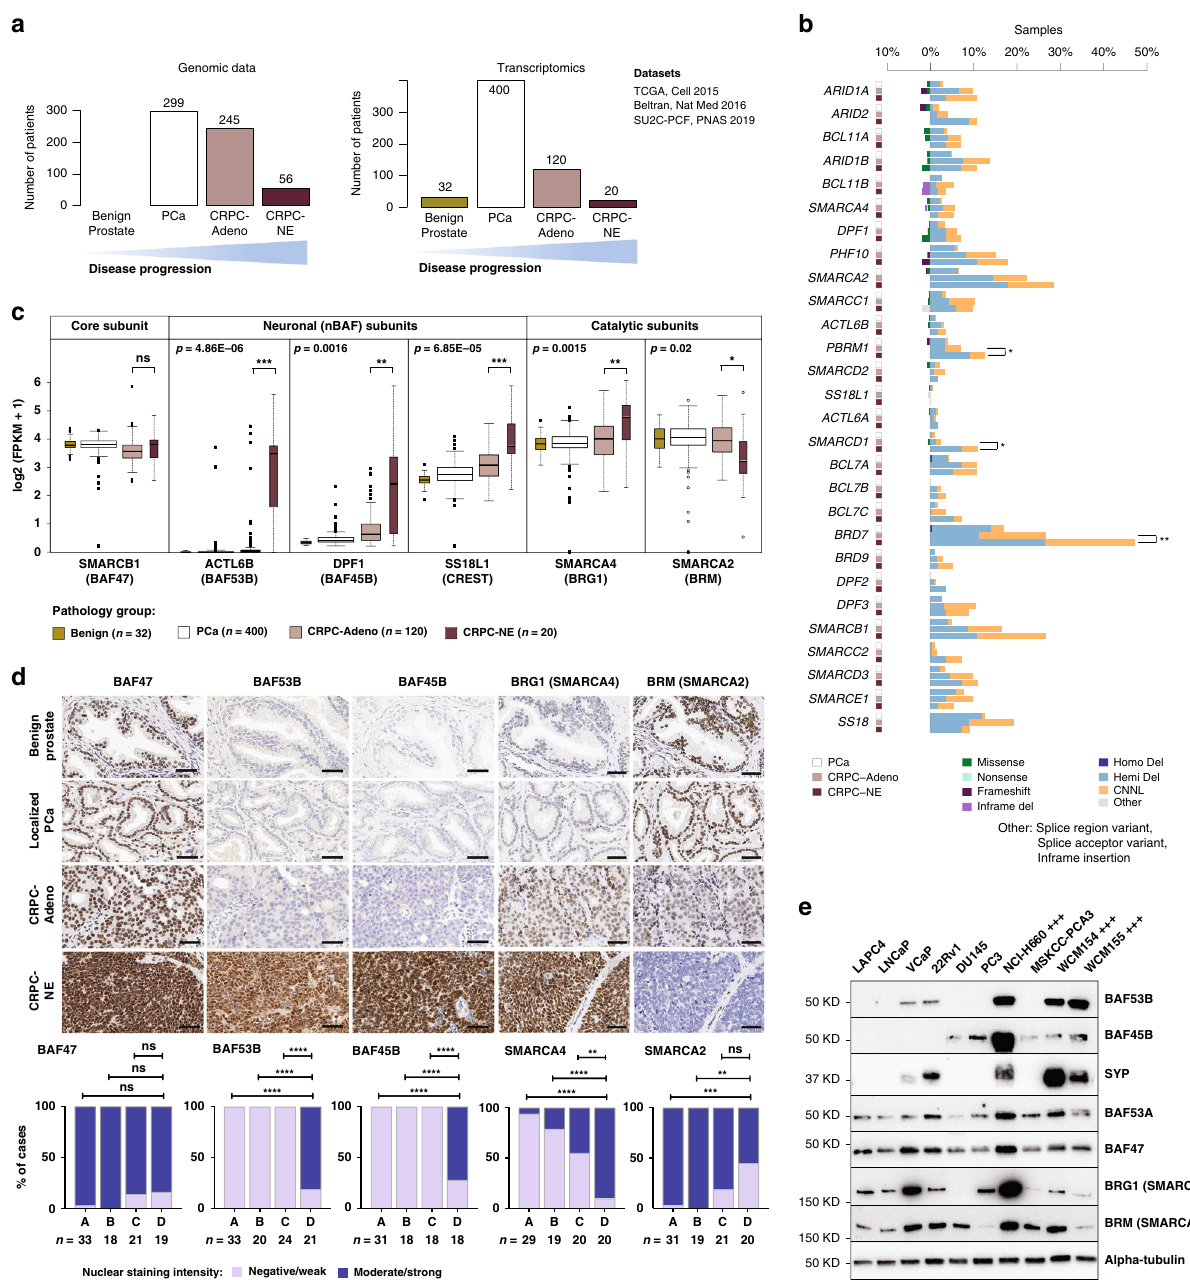
Fig. 1 Identi fi cation of SWI/SNF subunits deregulated in CRPC-NE. a Summary of the number of patients analyzed by whole exome sequencing (WES) and RNA-seq for each disease state. b WES results for SWI/SNF genes in 600 samples from unique PCa patients. For each gene, three consecutive bars represent alteration frequency in localized hormone treatment-naïve PCa, CRPC-Adeno and CRPC-NE, respectively. c RNA-seq analysis of gene expression levels in 572 unique patient samples from four studies, showing selected genes ( ACTL6B : p = 4.86E − 06, DPF1 : p = 0.0016, SS18L1 : p = 6.85E − 05, SMARCA4 : p = 0.0015, SMARCA2 : p = 0.02) signi fi cantly deregulated in CRPC-NE. The core subunit SMARCB1 is shown for comparison. The box plots represent the median values and the lower and upper interquartile range (IQR); the upper whisker = min(max(x), Q3 + 1.5 × IQR) and lower whisker = max (min(x), Q1 − 1.5 × IQR), and the outliers are plotted as individual points. d Representative immunostainings against BAF47 ( SMARCB1 ), BAF53B ( ACTL6B ), BAF45B ( DPF1 ), BRG1 ( SMARCA4 ) and BRM ( SMARCA2 ), and statistical analysis of staining intensity in patient samples. A-benign prostate glands, B- hormone treatment-naïve localized PCa, C-CRPC-Adeno, D-CRPC-NE. ** p < 0.01 ( p = 0.0057 for BRG1, p = 0.0012 for BRM), *** p < 0.001 ( p = 0.0004 for BRM) and **** p < 0.0001, ns indicates not signi fi cant (two-sided Fisher ’ s exact test). Scale bars, 50 μ m. e Immunoblot showing expression levels of selected SWI/SNF subunits in PCa cell lines ( +++ designates CRPC-NE cell lines). Benign: benign prostatic tissue, PCa: localized hormone treatment- naïve prostate cancer, CRPC-Adeno: Castration resistant prostate cancer, adenocarcinoma subtype, CRPC-NE: Castration resistant prostate cancer, neuroendocrine subtype. Source data are provided in the Source Data fi